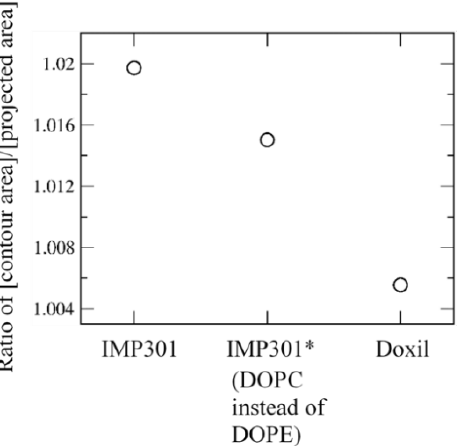
Figure 10. The ratio of [contour bilayer-surface area]/[projected bilayer-surface area] for IMP301, IMP301* (including DOPC instead of DOPE), and DOXIL.